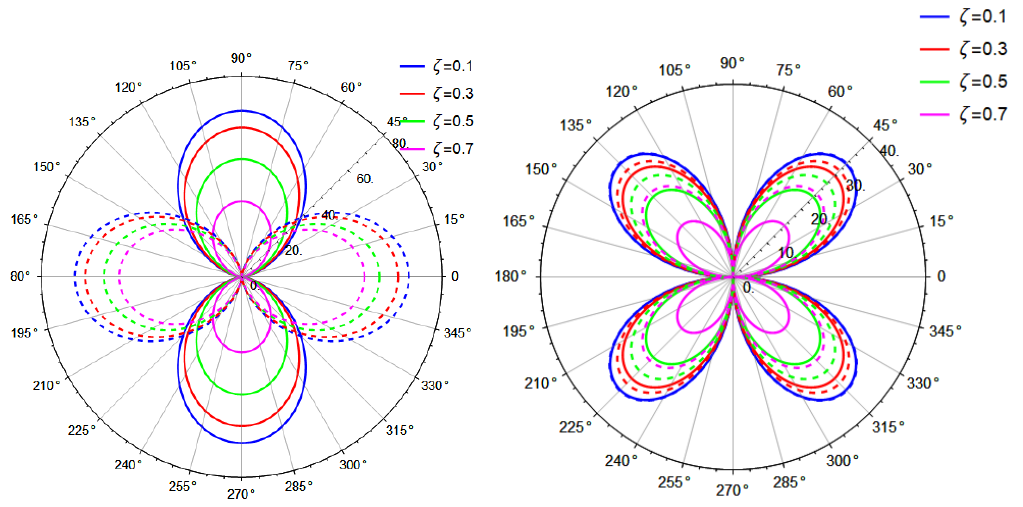
Figure 3: Temperature dependence of the poles of Eq. (73) in units of i [ τ = ζ = 0.1 fixed ζ x y